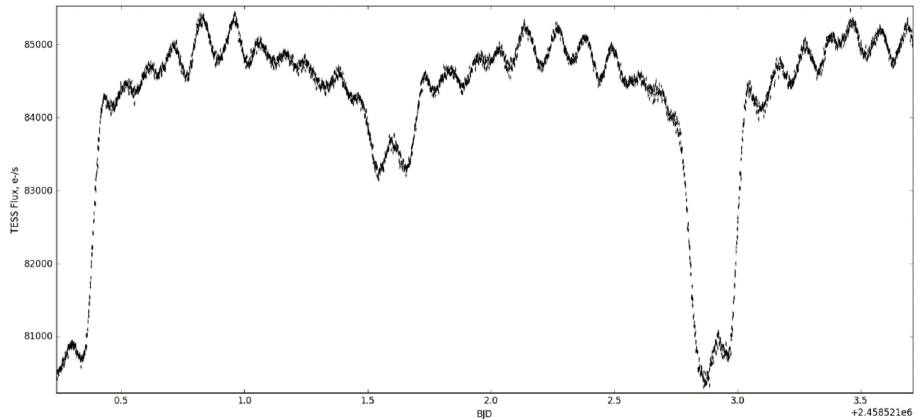
Fig. 2. The light curve of V438 Vel from the TESS space telescope. The high amplitude 0.132-day pulsations are clearly